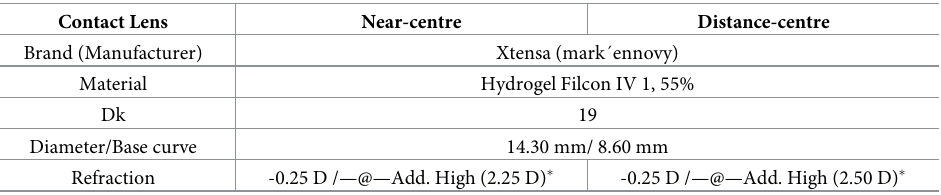
Table 1. Contact lens